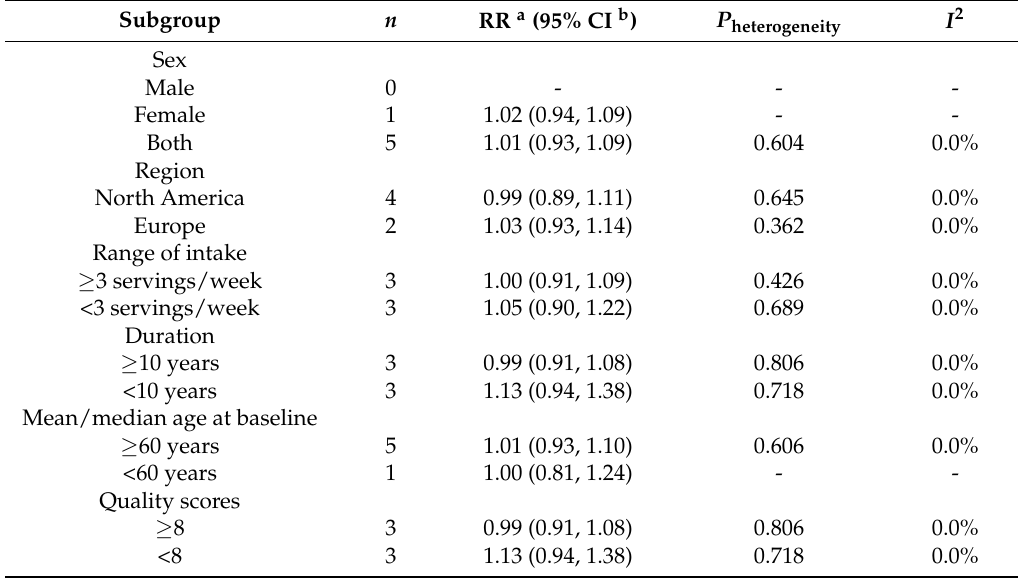
Table 2. Subgroup analysis for the association of fish consumption and AF risk (highest vs.